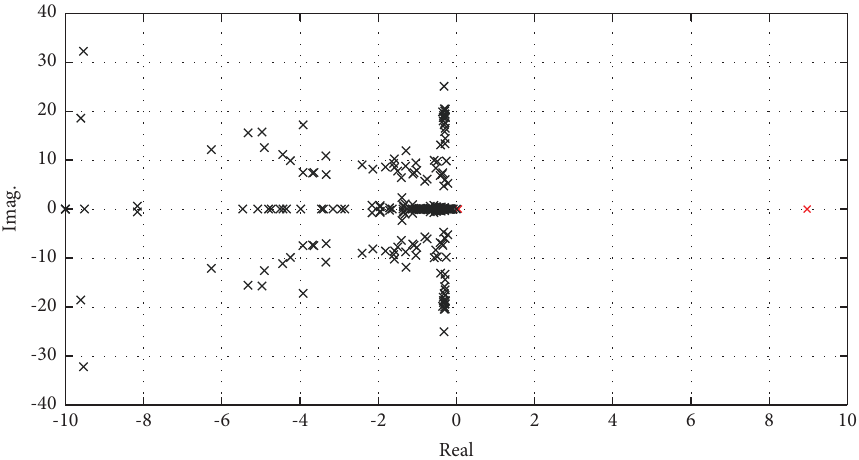
Figure 11: Eigenvalues in the basic operating point for IEEE 118-bus system.